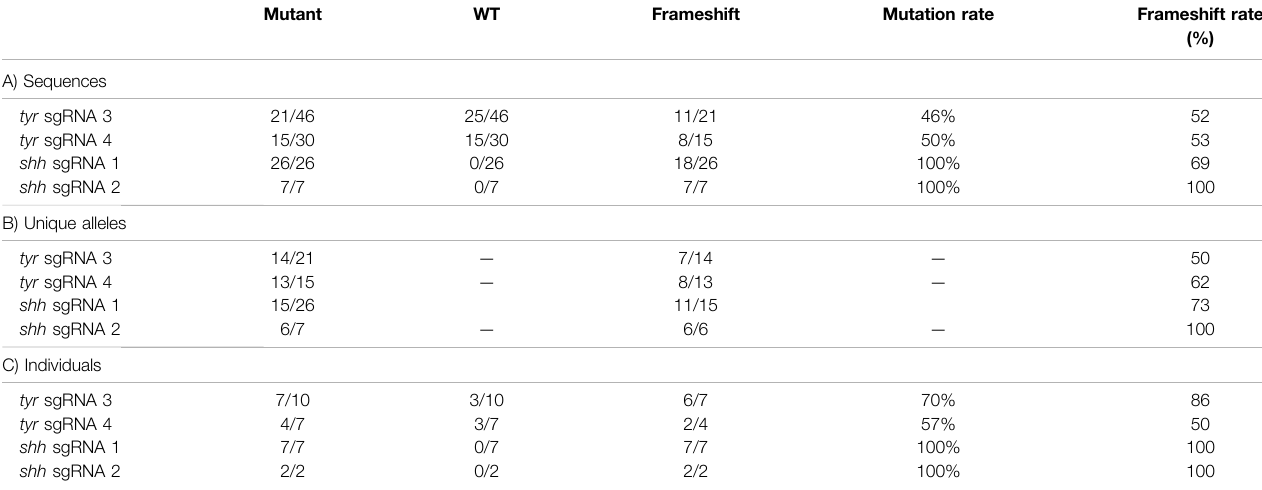
TABLE 4| Summary ofsterlet Δ tyr larvae and Δ shh embryos genotyping. A) all obtained sequences from all genotyped individuals pooled together, B) unique alleles from all genotypedindividualspooledtogether,C)allgenotypedindividuals.ThedenominatornumbersinArepresentallobtainedsequencesfromallindividualsgenotypedfora respective locus, and similarly in B, the denominators show the total number of mutant alleles obtained from sequencing all individuals. In C, the denominators indicate the total numbers of genotyped individuals for each respective locus. Mutation and frameshift rates are calculated for each row, i.e. they represent percentages of mutant sequences and unique alleles from all sequences obtained by genotyping all individuals pooled together in A and B, respectively, while they show percentages of genotyped individuals with mutant/frameshifted genotypes in